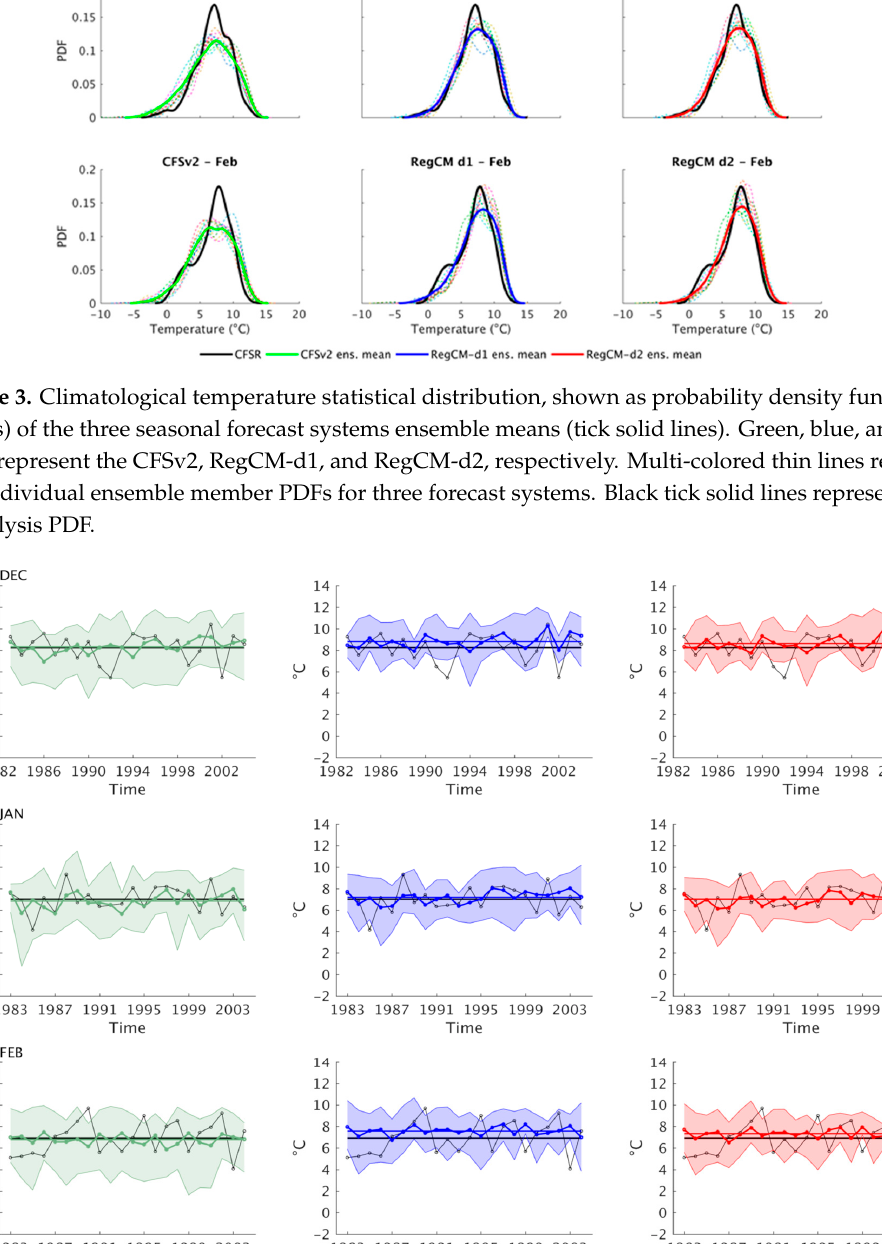
for the three SFSs are shown using shaded colors. Reanalysis and SFSs are spatially averaged in correspondence of the inner domain centered over Central Italy. In term of climatological means, CFSv2 seems to reproduce extremely well the reanalysis data over the three lead times. However, it must be considered that it could represent an artifact originated by spatially averaging the negative and positive biases shown in Figure 2. For what concerns the inter-annual variability, the driving CFSv2 largely underestimates the reanalysis variability. The CFSv2 capability of reproducing the temporal sequence of temperature above or below the mean is fairly poor and also characterized by a relevant ensemble spread which can reach values up to 7–8 °C. Downscaled SFSs improve the information about the inter-annual variability, especially on the second part of the climatological period time series and on the 1-month forecast lead time. The ensemble spread is also consistently reduced. Coherently, where CFSv2 misses to represent extreme monthly values (i.e., largely departing from the climatological mean), the downscaled simulations also fail to represent anomalous monthly values.